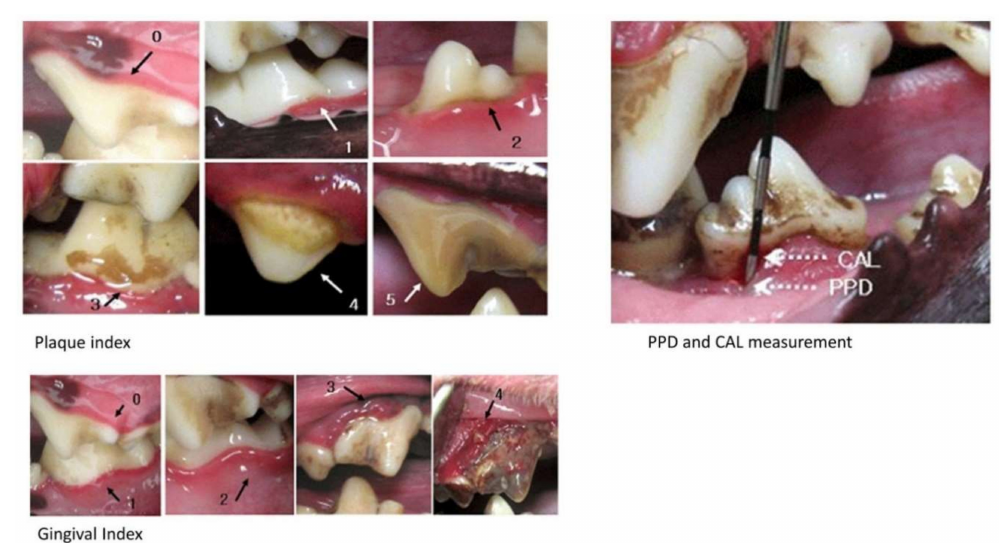
Figure 1. Clinical parameters for gingivitis. Arrows indicate the corresponding grades for Plaque index, and Gingival index as defined in the Table 2. PPD: probing pocket depth and CAL: clinical attachment